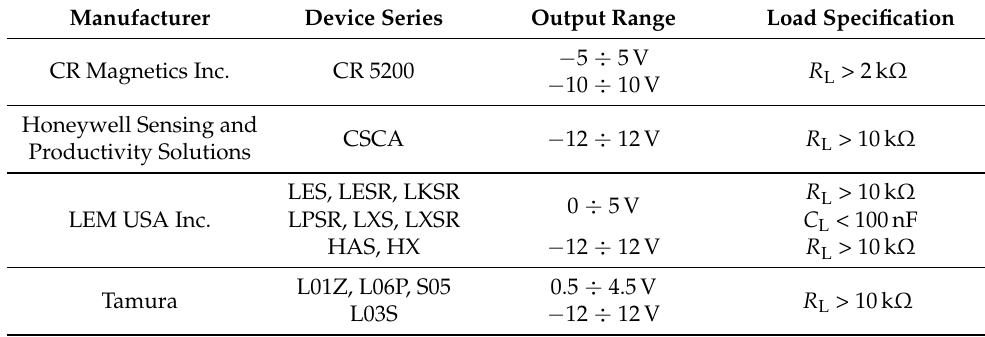
Table 1. Specifications of commercial current sensor based on the Hall effect.